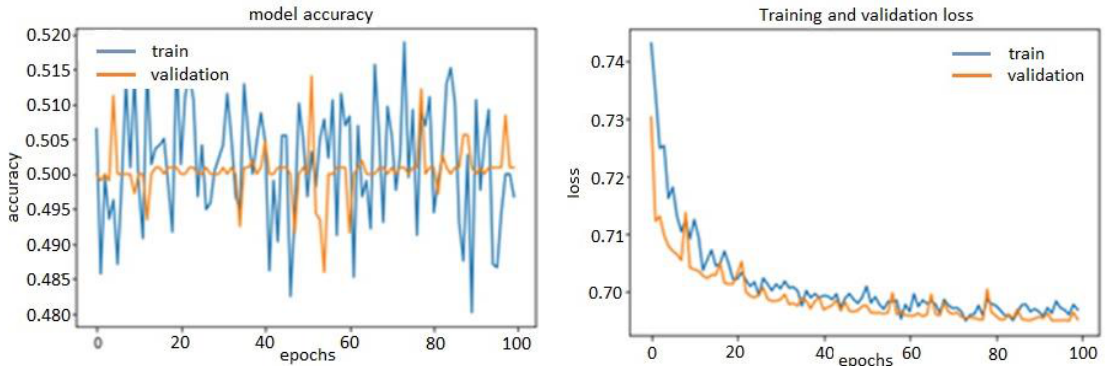
Figure 14. Accuracy and loss model of time-domain features_1D-CNN.